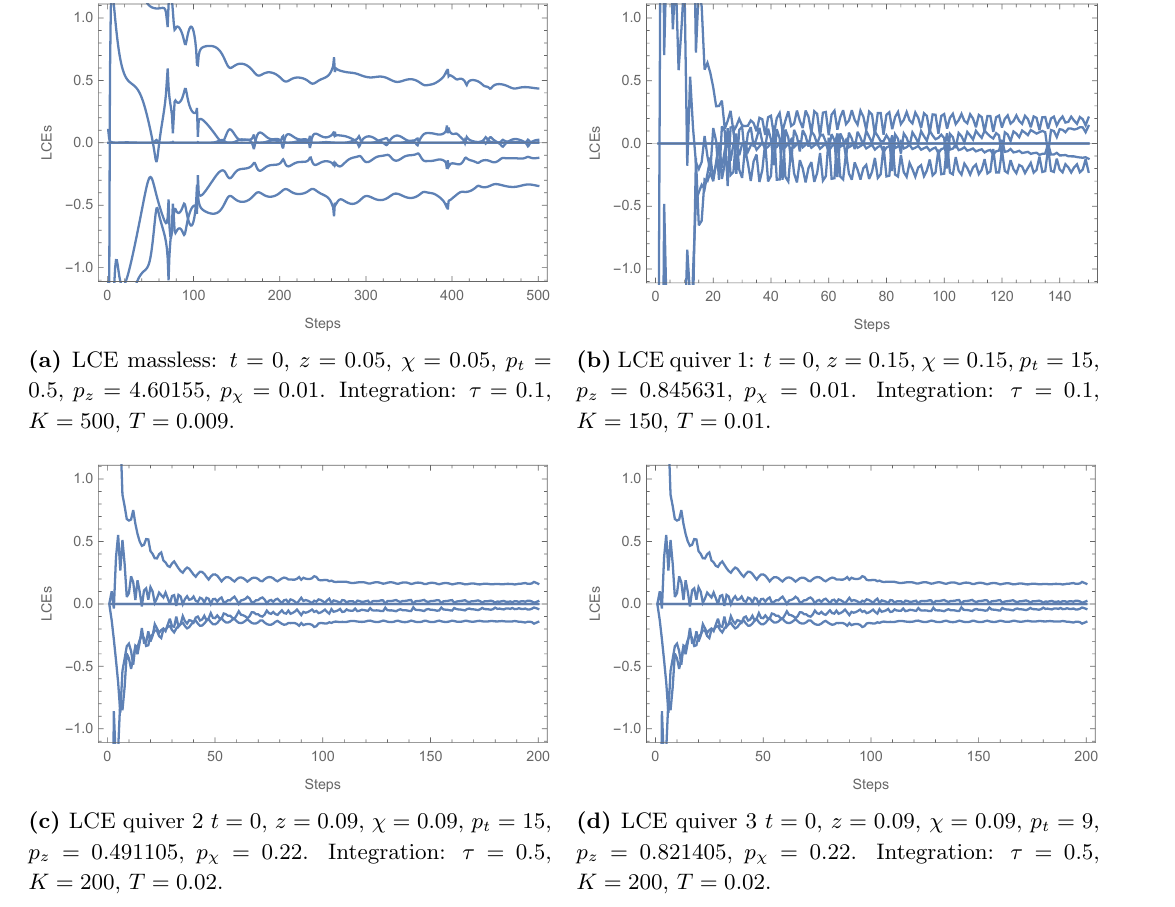
Figure 10. LCEs for di(cid:11)erent